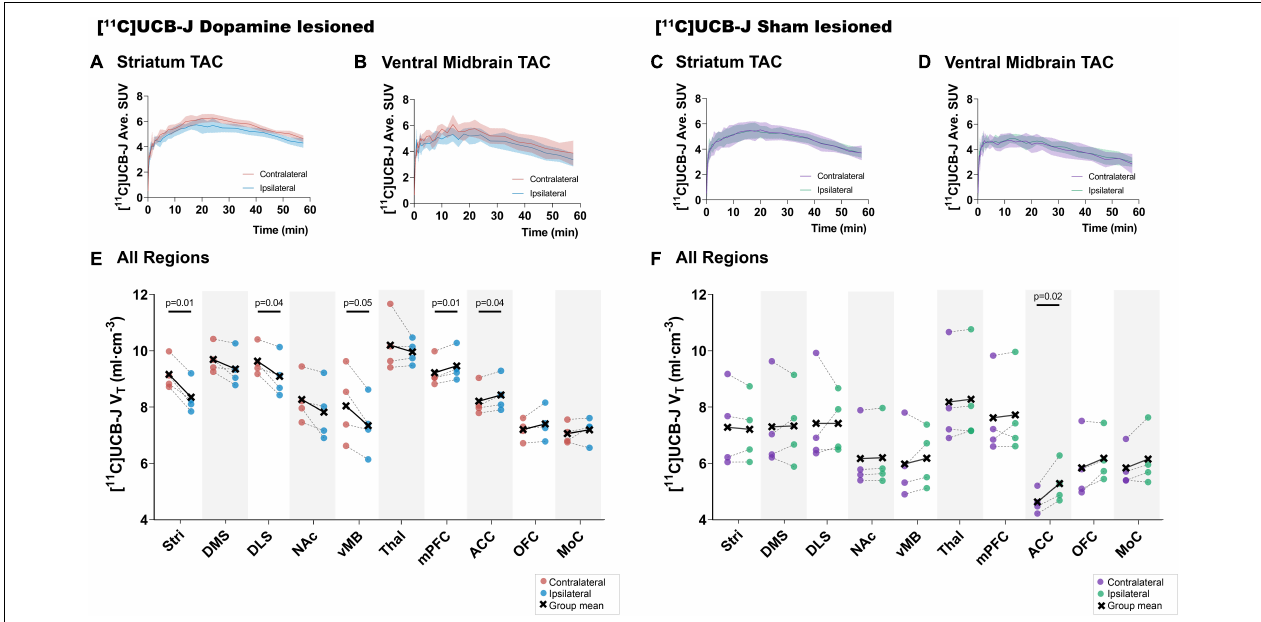
FIGURE 4 | Average [ 11 C]UCB-J binding. Average time-activity curves from all the animals in the striatum (A,C) and ventral midbrain (B,D) . Comparison of ipsilateral and contralateral [ 11 C]UCB-J V T values in the selected regions of interest within the dopamine lesioned (E) and sham lesioned (F) rats. Notable differences are marked with their p values. Stri = striatum, DMS = dorsomedial striatum, DLS = dorsolateral striatum, NAc = nucleus accumbens, vMB = ventral midbrain, Thal = thalamus, mPFC = medial prefrontal cortex, ACC = anterior cingulate cortex, OFC = orbitofrontal cortex, MoC = motor cortex. TABLE 1 | Group-wise summary of the paired t -test between the ipsilateral and contralateral regions for each tracer and group.